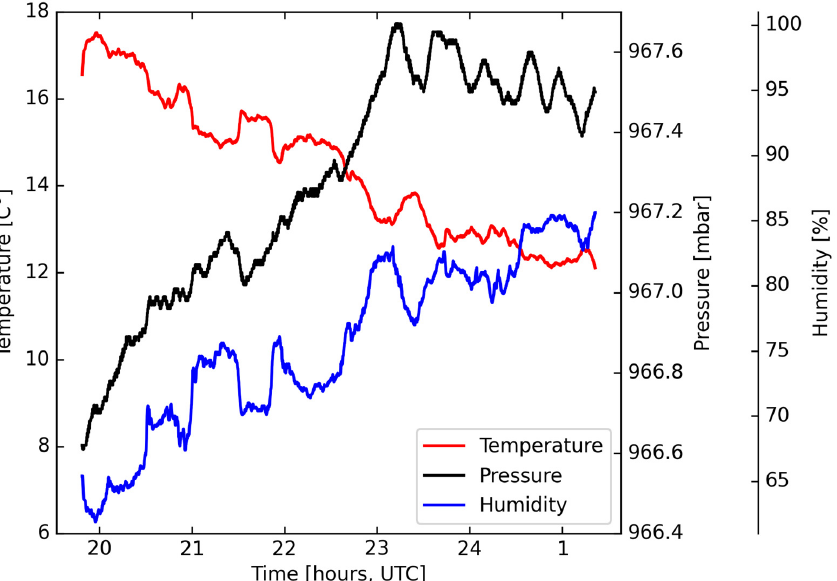
Figure 9. Logged temperature, pressure and humidity data of VESTA meteo sensor, August 8.